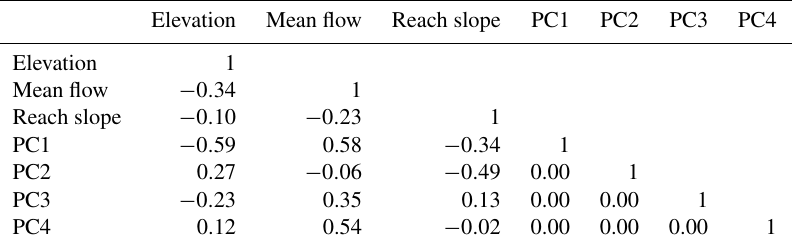
Table 5. Correlations among stream temperature principal components and spatial attributes of 226 monitoring sites with annual data from river networks in the northwestern United